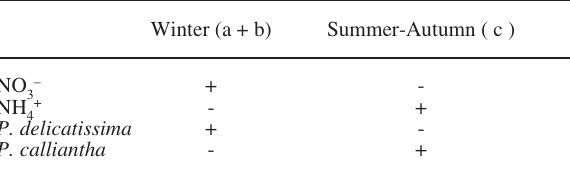
Table 4. – Summary of statistical analyses performed on data col- lected from alfacs Bay. two groups were defined distinguishing winter (cluster groups a and b ) from summer and autumn (cluster group c ) (see text). these groups were characterised by high (+) or low (-) concentrations of no 3¯ and nh 4+ and by high (+) or low (-) cell abundances of Pseudo-nitzschia delicatissima and P. callian- tha . other variables did not play a significant role.